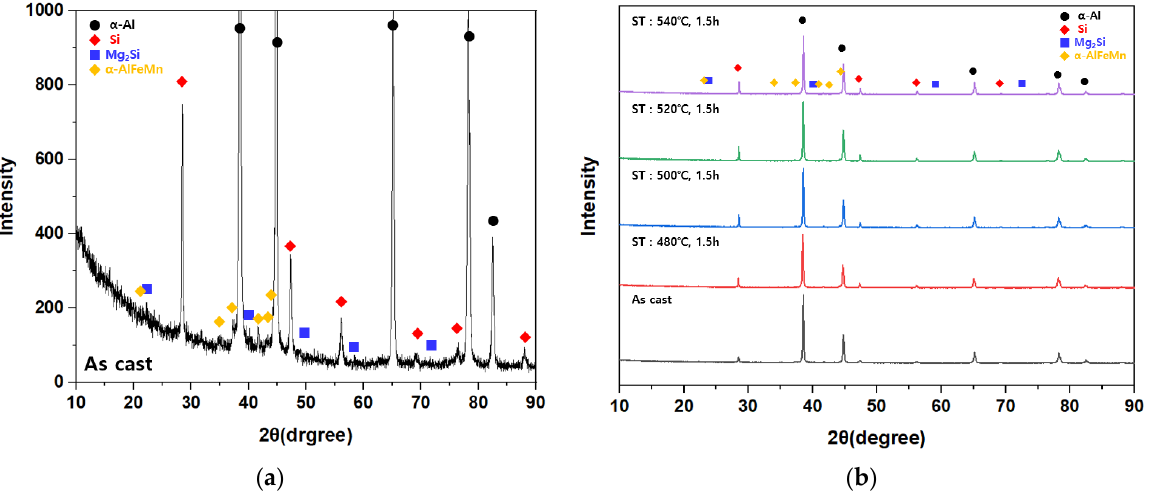
Figure 3. Optical micrographs of the specimens ( a ) as-cast, and after solution treatments at ( b ) 480